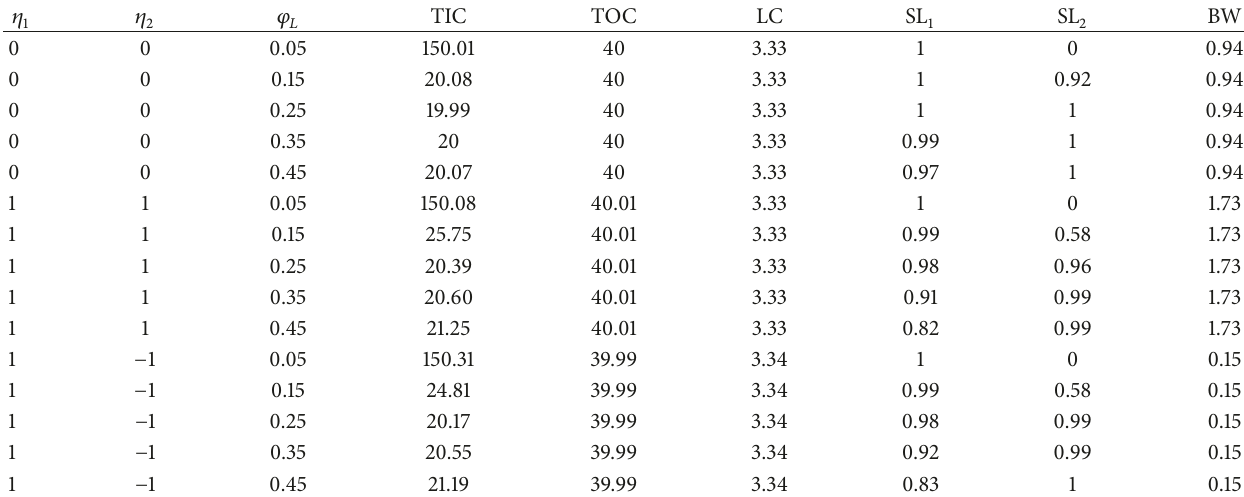
Table 3: The results on system performance in scenario 𝜉 2